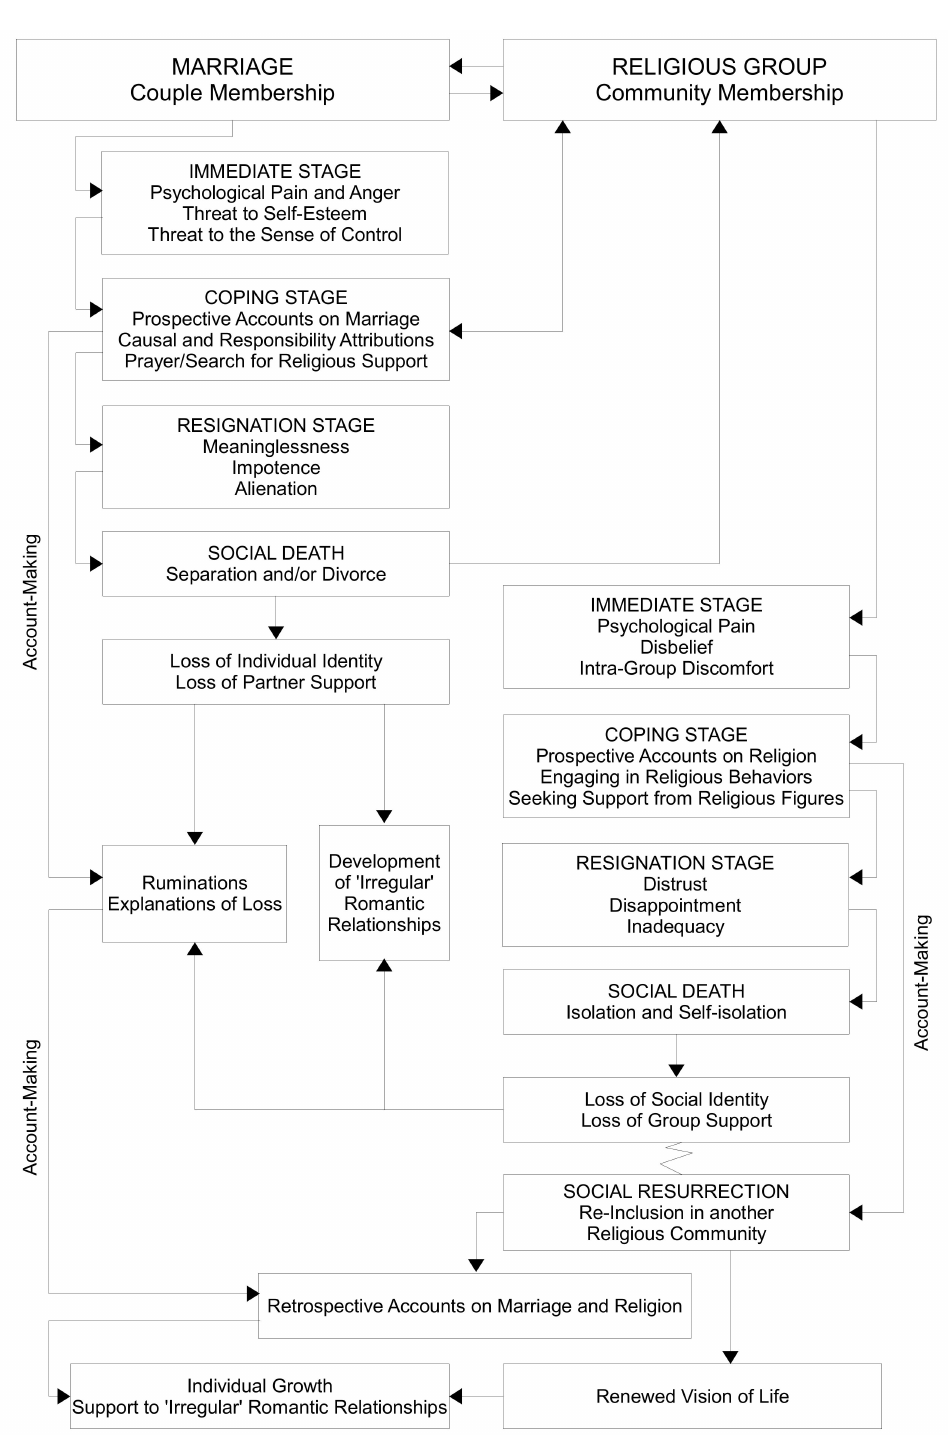
Figure 1. Timeline tree of cumulative